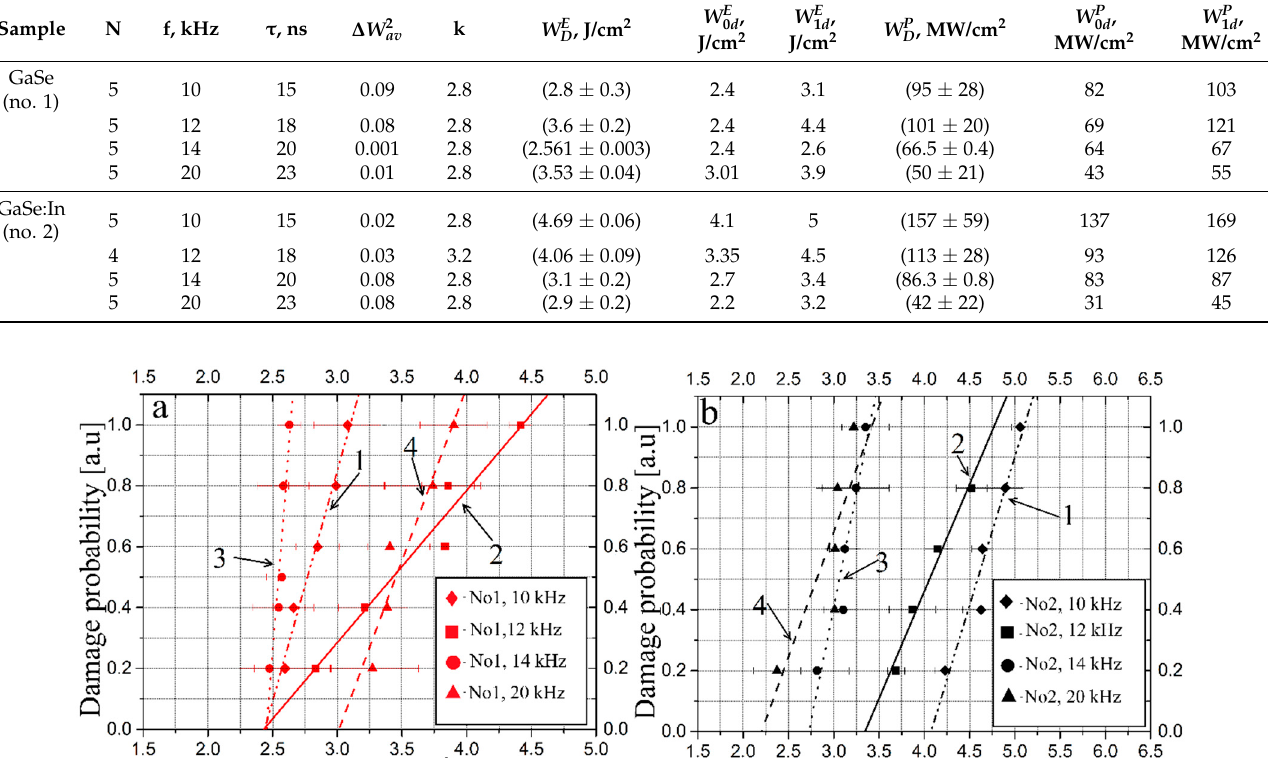
Table 2. Laser-induced damage threshold (LIDT) results for GaSe: the values of fluence W E and peak power W P with 0 d 0 d LIDT probability equal to 0, the values of fluence W E and peak power W p with LIDT probability equal to 1, the average 1 d 1 d value of fluence W E and peak power W P taking into account the measurement error; Student’s coefficient k at confidence √ D D probability—0.95, standard deviation— s 2 , number of measurements—N.